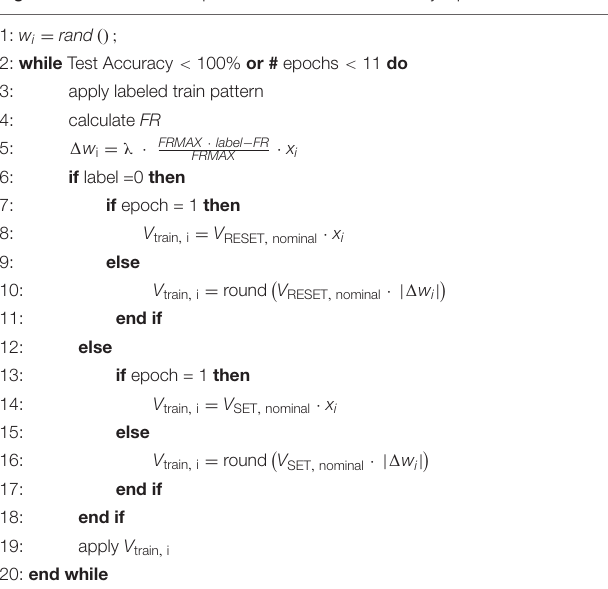
minimum firing rate of the neuron FRMAX and 0, respectively.